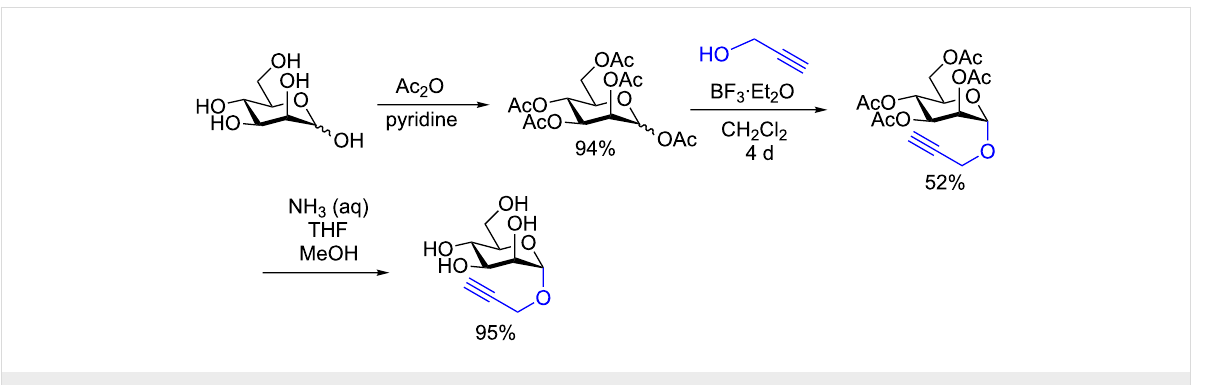
Scheme 18: Synthesis of the mannosyl donor used in the study